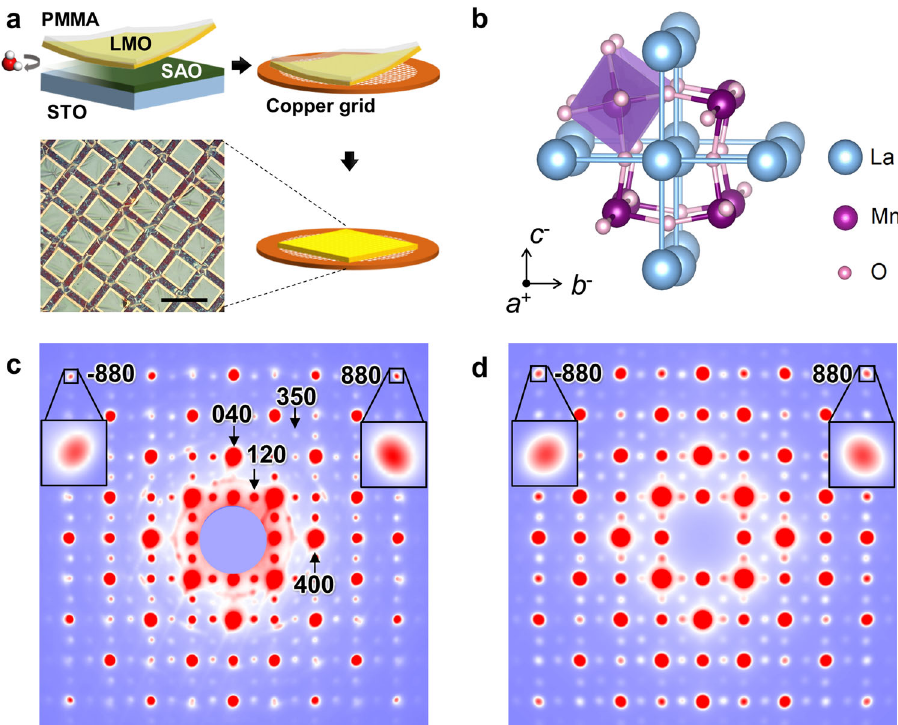
Fig. 1 Freestanding LaMnO 3 fi lm and its lattice dynamics measured by MeV-UED. a Top: Schematic of the freestanding LMO fi lm achieved by removing the SAO buffer layer grown on the STO substrate. Bottom: Optical microscopy image of the LMO fi lm on the copper mesh grid for UED experiments. The scale bar is 100 µm. b Schematic of orthorhombic structure of LaMnO 3 . c The experimental [001] UED pattern obtained before photoexcitation from the freestanding LaMnO 3 fi lm. The transmitted beam was not included to avoid saturation of the detector. The bright spots marked as ( h k 0) with ( h, k ) being (even, even), (odd, even), (even, odd), and (odd, odd) correspond to the Bragg re fl ections and superlattice re fl ections from the a + b − c − , a − b + c − , and a − b − c + twin variants, respectively. The ( − 880) and (880) spots are magni fi ed showing their elliptical shape along the [110] * and [ − 110] * direction, respectively. d Simulated UED pattern based on the Bloch- wave method with the twin variants, showing good agreement with the